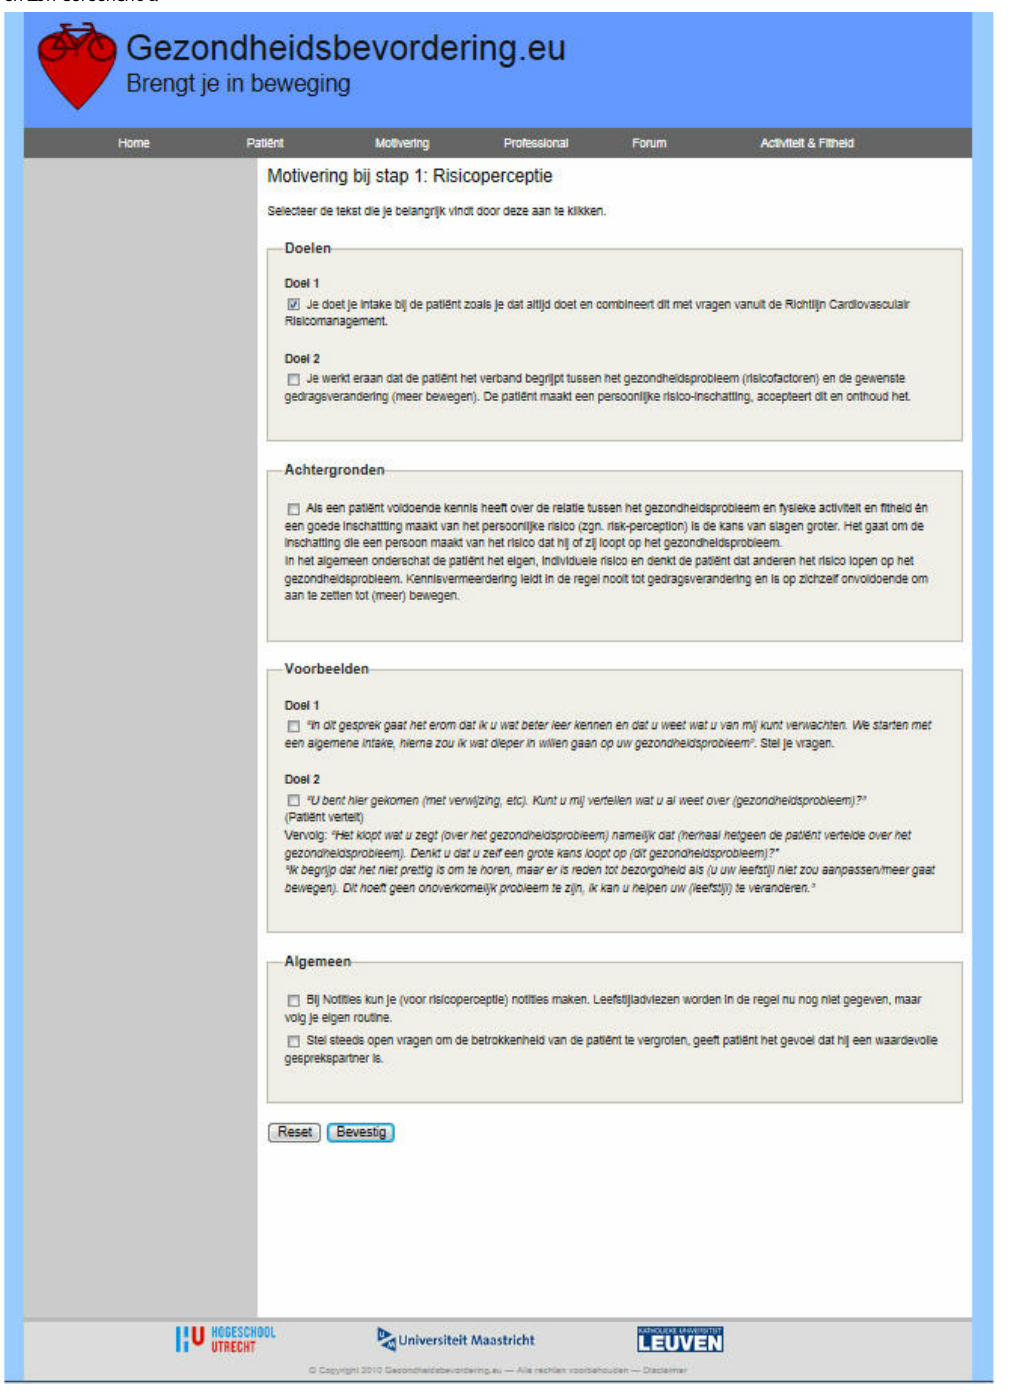
Figure 3. Intervention